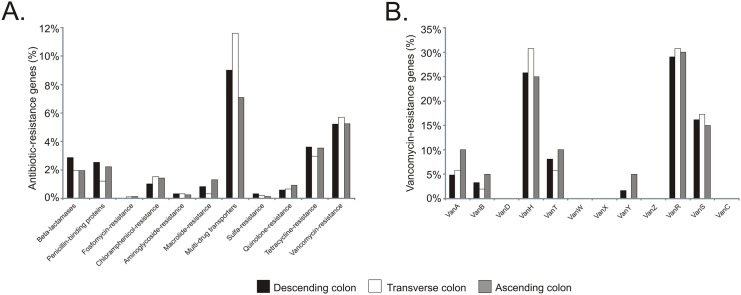
Percentage of putative antibiotic-resistance genes in mummified gut.Panel A shows the percentage of hits to genes associated with beta-lactamases, penicillin-binding proteins, resistance to fosfomycin, chloramphenicol, aminoglycosides, macrolides, sulfa, quinolones, tetracycline and vancomycin, and multi-drug transporters. Panel B shows the percentage of vancomycin genes including vanA, vanB, vanH, vanT, vanY, vanR and vanS.